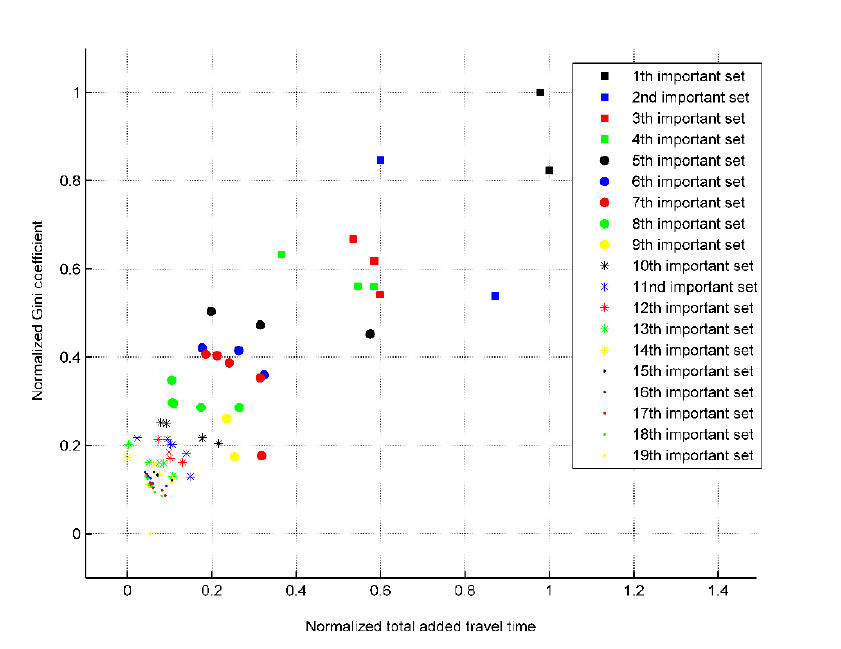
The results of non-dominated